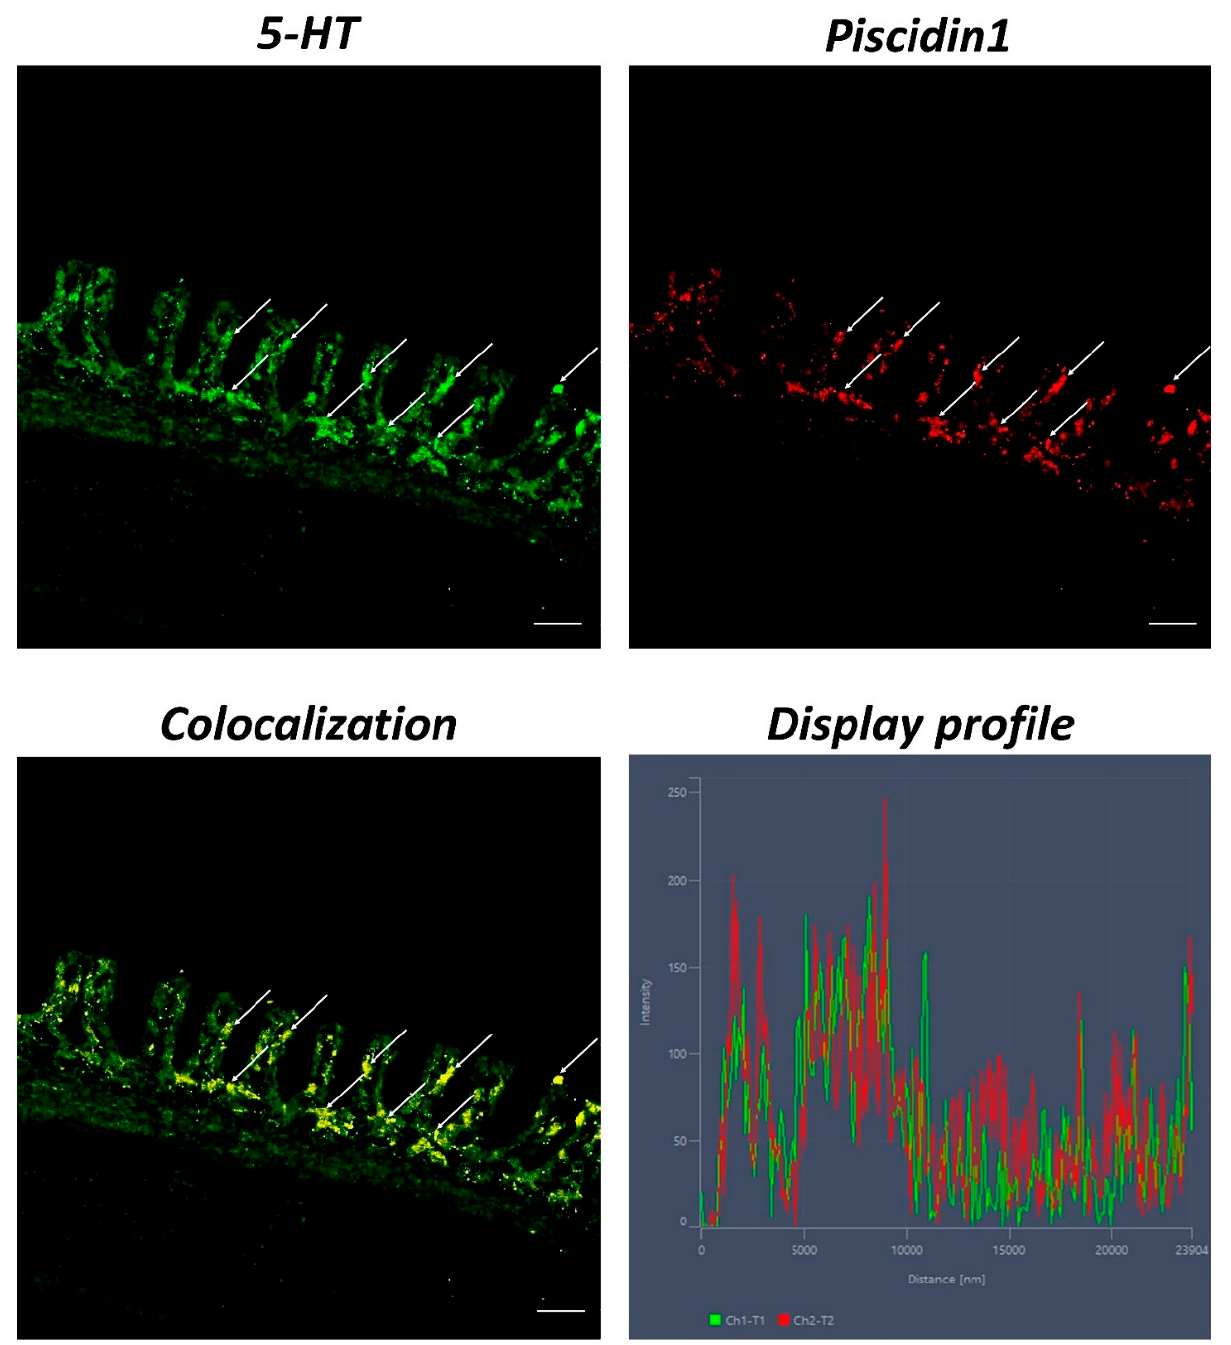
Figure 4. Section of the gill of giant mudskipper, immunofluorescence of 5-HT and Piscidin1, 40×, scale bar 40 μ m. MCs positivity to 5-HT (green) and Piscidin1 (red) can be clearly seen (arrows). The colocalization of the antibodies is confirmed by the ‘display profile’ function.